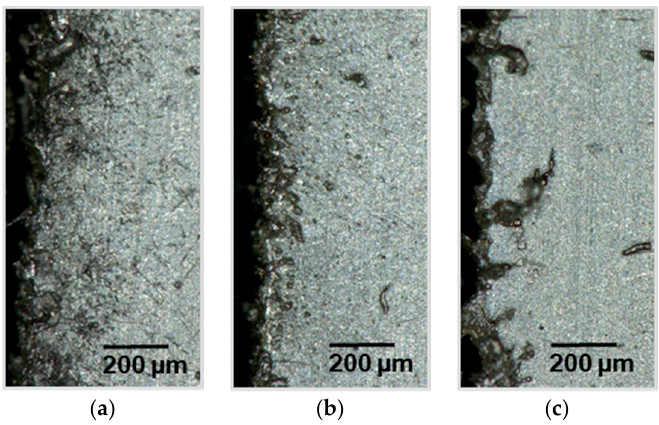
Figure 12. Light microscope sections of a laser cut lithium sheet: 72.8 W, 100 mm/s; ( a ) 70 kHz, 240 ns, PO 98.41%; ( b ) 200 kHz, 55 ns, PO 99.44%; ( c ) 350 kHz, 26 ns, PO 99.68%.